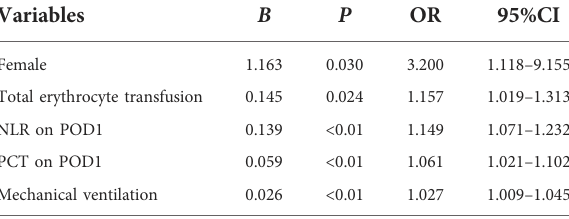
TABLE 4 Independent risk factors of off-pump CABG-associated AKI.